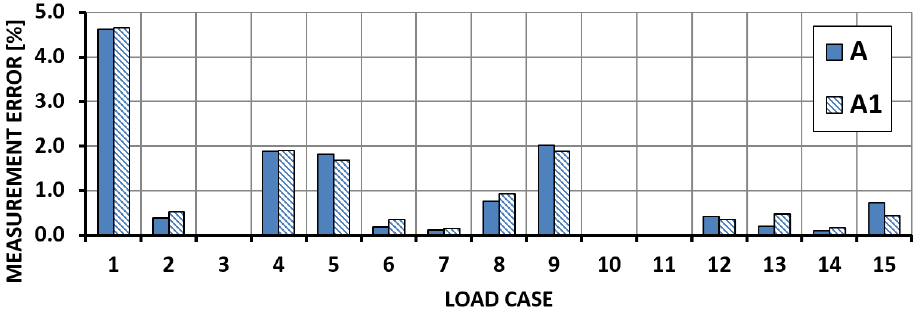
Figure 13. Bending moment measurement error—Section II.